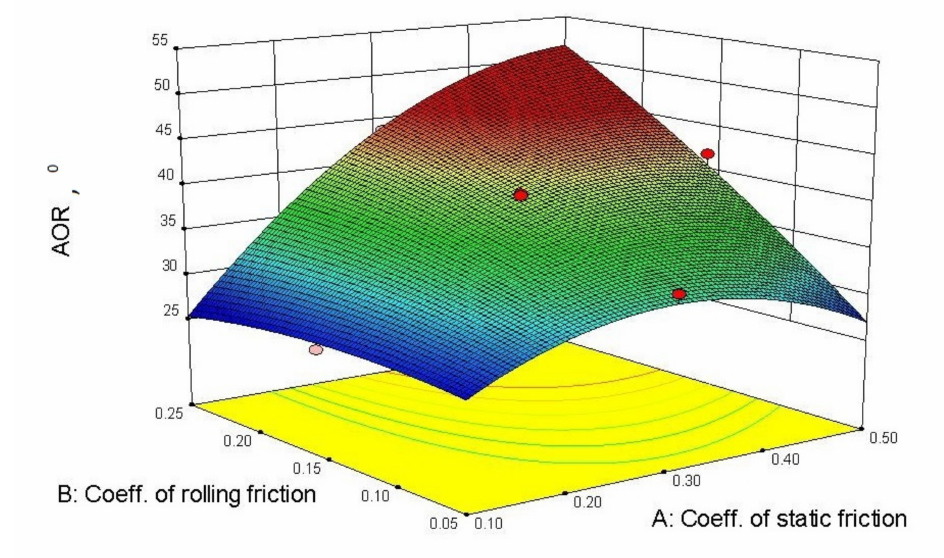
Figure 14. Response surface of the AOR versus the AB interaction.